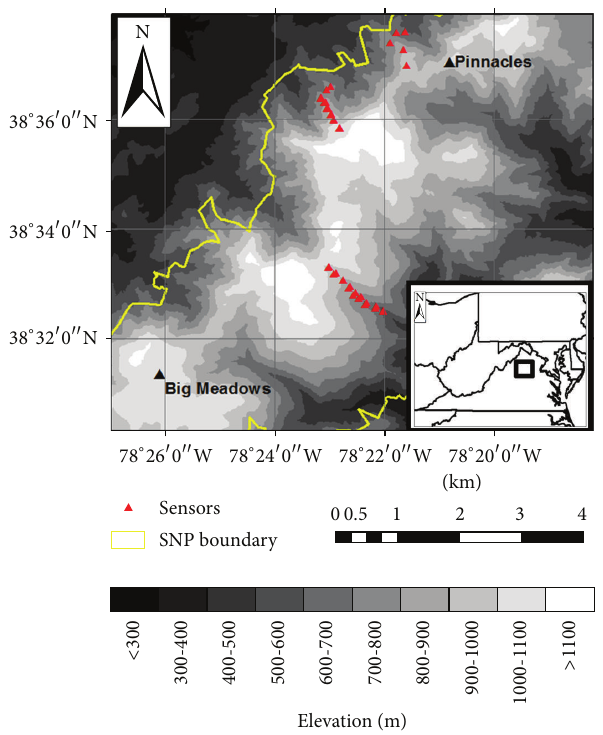
Figure 2: Location of experimental site within Virginia (black box in the inset map) and map of the study area. The red triangles and yellow line indicate the locations of the temperature sensors and the Shenandoah National Park boundary, respectively. The two ridgetop climatemonitoringstations,BigMeadowsandPinnacles,arelabeled and shown with a black triangle. Shading indicates elevation.